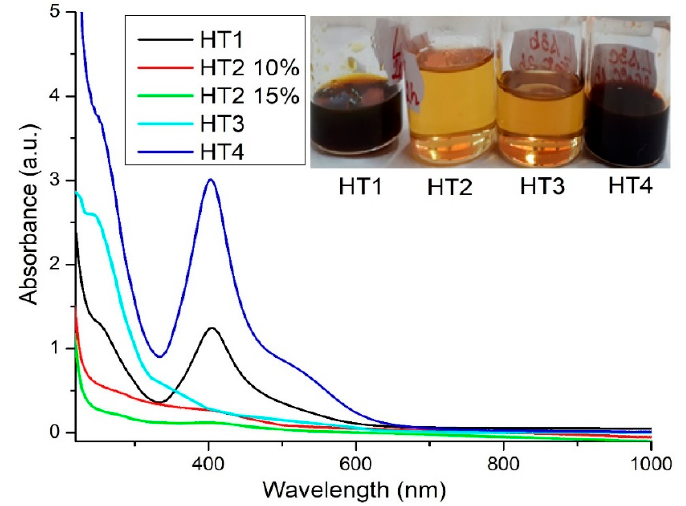
Figure 9. UV-VIS spectra of solvothermal synthesis with PEG and PVP. Figure 9. UV- VIS spectra of solvothermal synthesis with PEG and PVP .